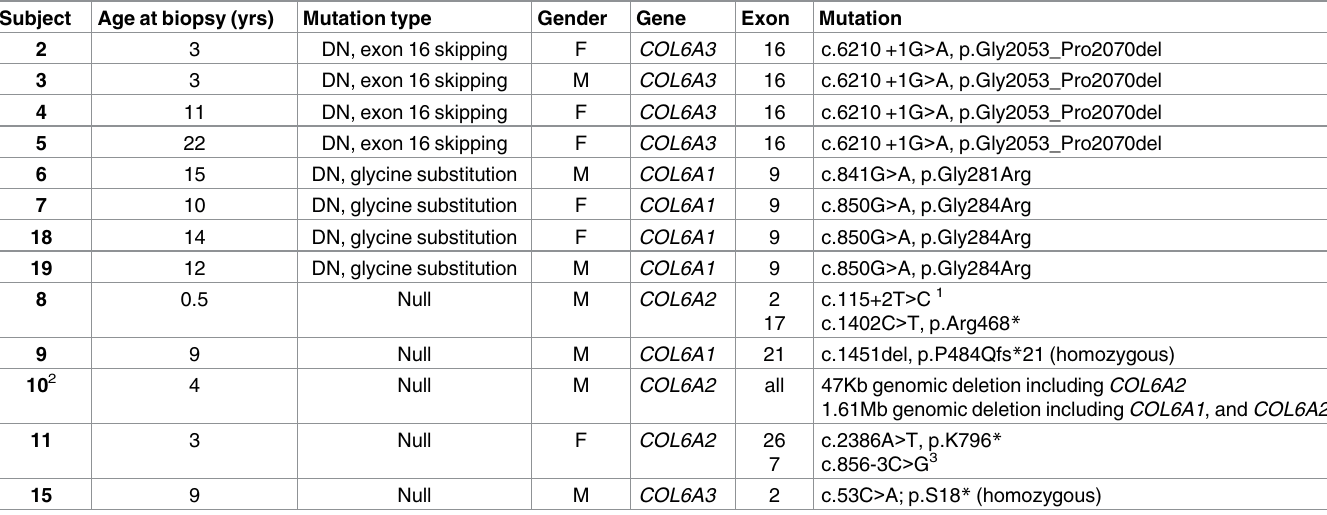
Table 1. Mutations in COL6-RD subjects with RNA-seq.